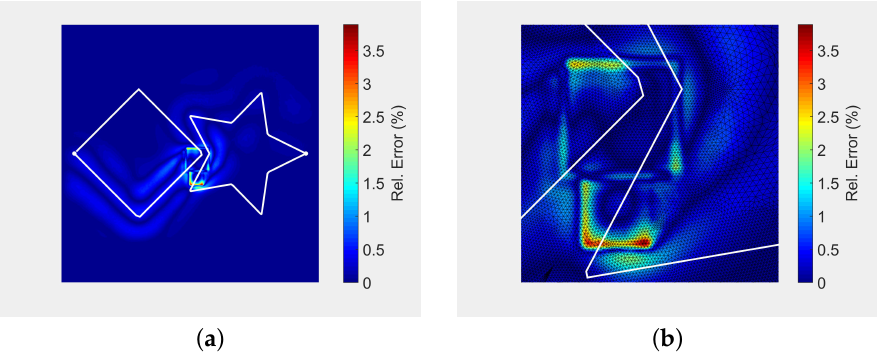
Figure 5. Appraisal of our analytic solution (Figure 3d) vs. the FEA solution (Figure 4c). ( a ) relative error. Analytic solution w.r.t. FEA (max. relative error: 3.9%); ( b ) 10 x zoom on Figure